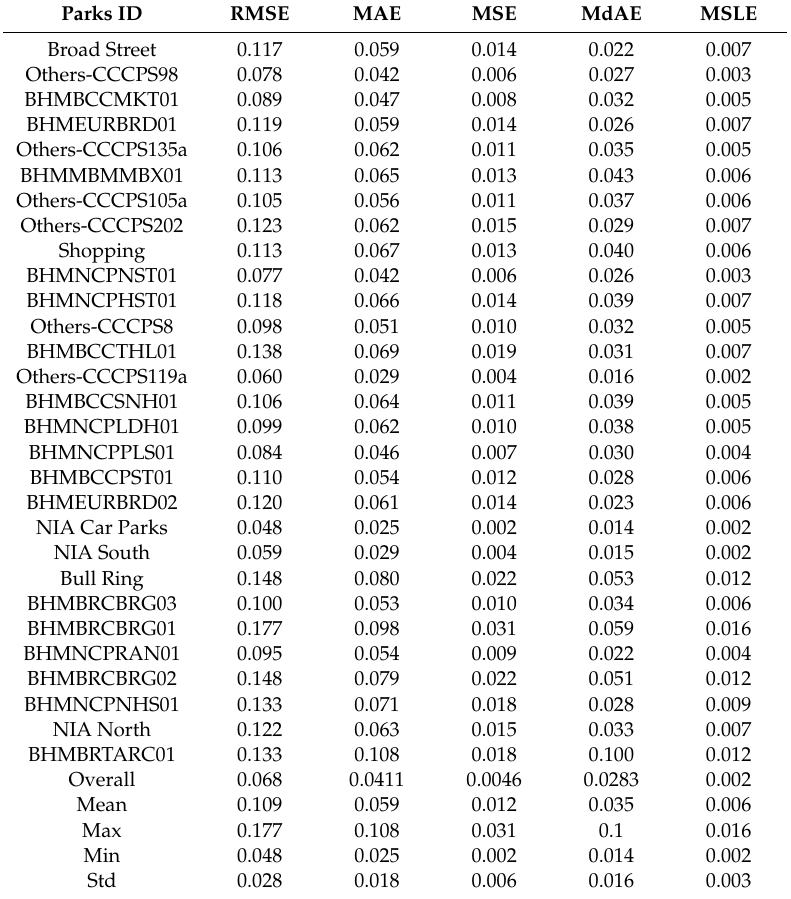
Table 3. Results of deep LSTM for parking availability prediction against each parking location